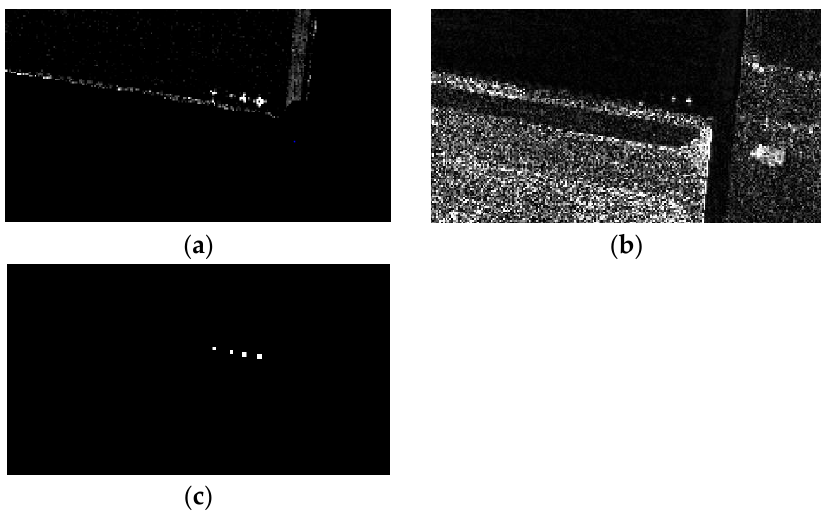
Figure 19. Metal plates data set. ( a ) Emissivity domain; ( b ) radiance domain; and ( c ) ground-truth map.